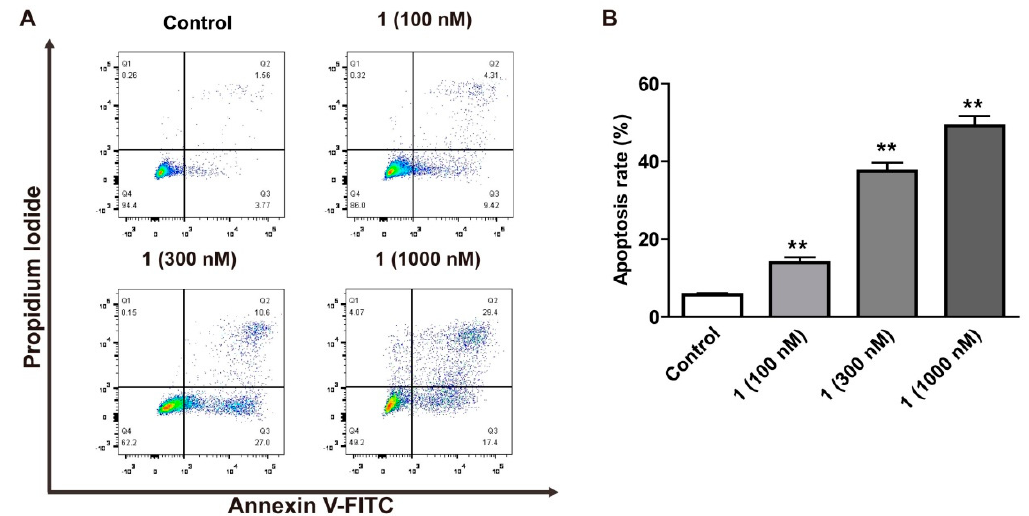
Figure 3. The effect of compound 1 on apoptosis in HepG2 cells. ( A , B ) Cells stained by annexin V-FITC and PI were measured using flow cytometry. The results were presented as mean ± SD ( n = 3). Compared with the control group, ** p < 0.01.